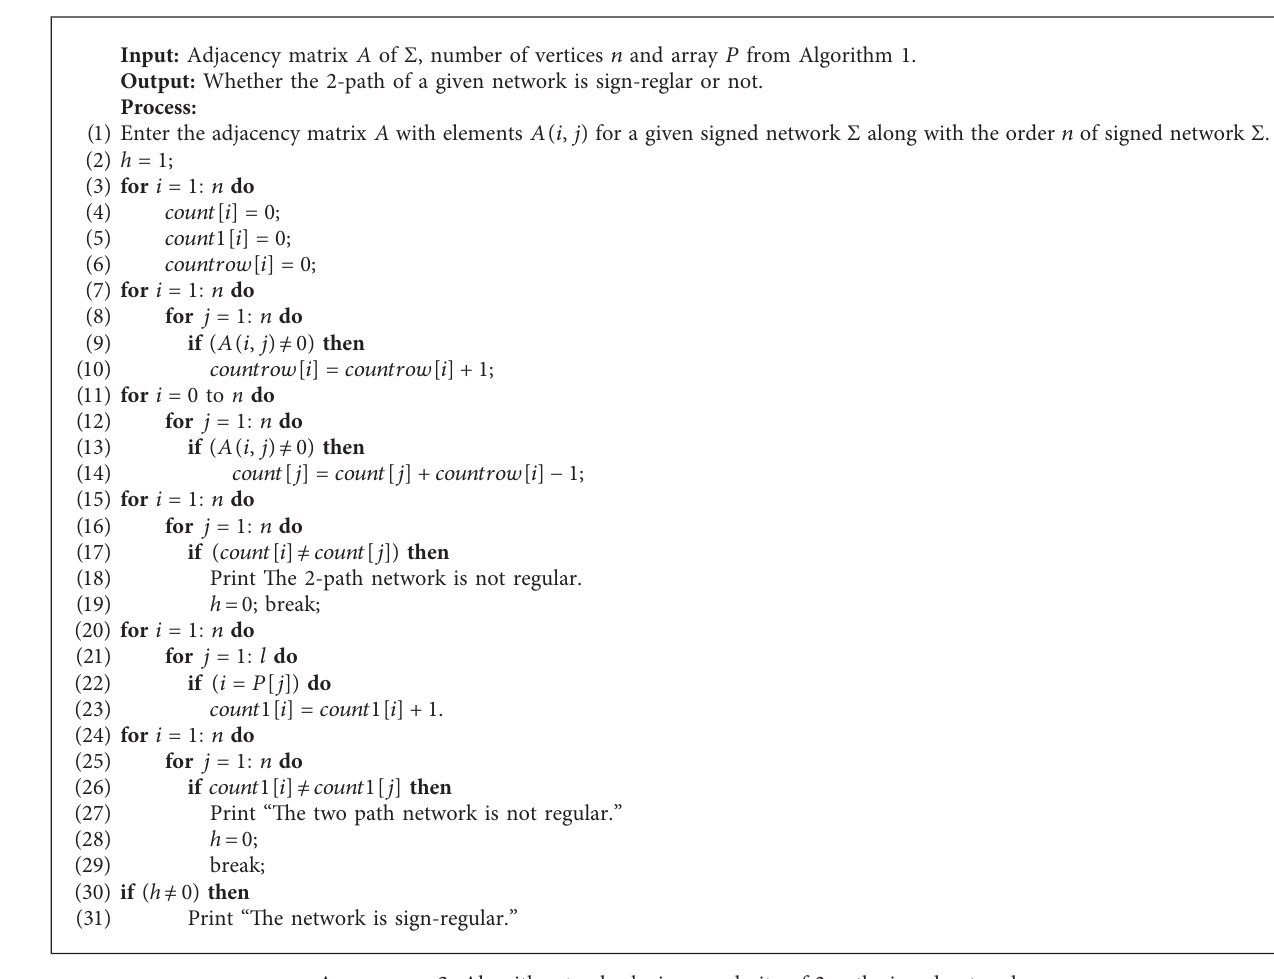
A LGORITHM 3: Algorithm to check sign-regularity of 2-path signed